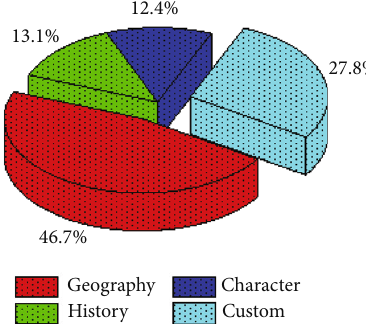
Figure 5: The key points of Ming envoys focus on.